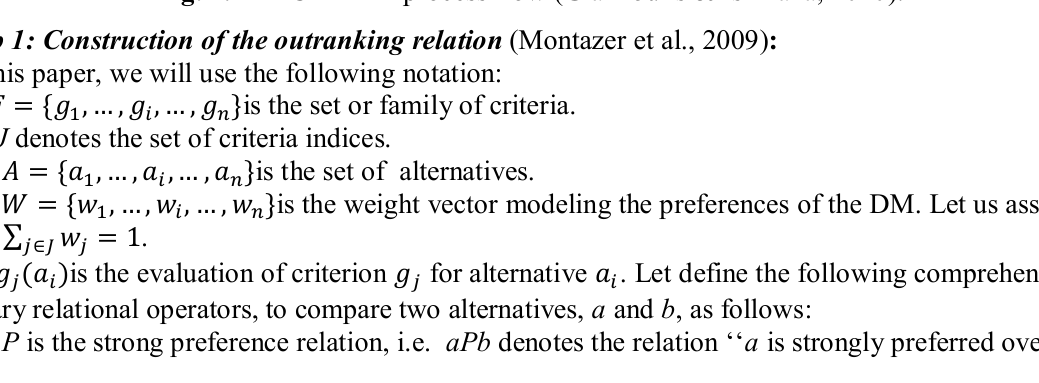
Fig. 1. ELECTRE III process flow (Giannoulis & Ishizaka,